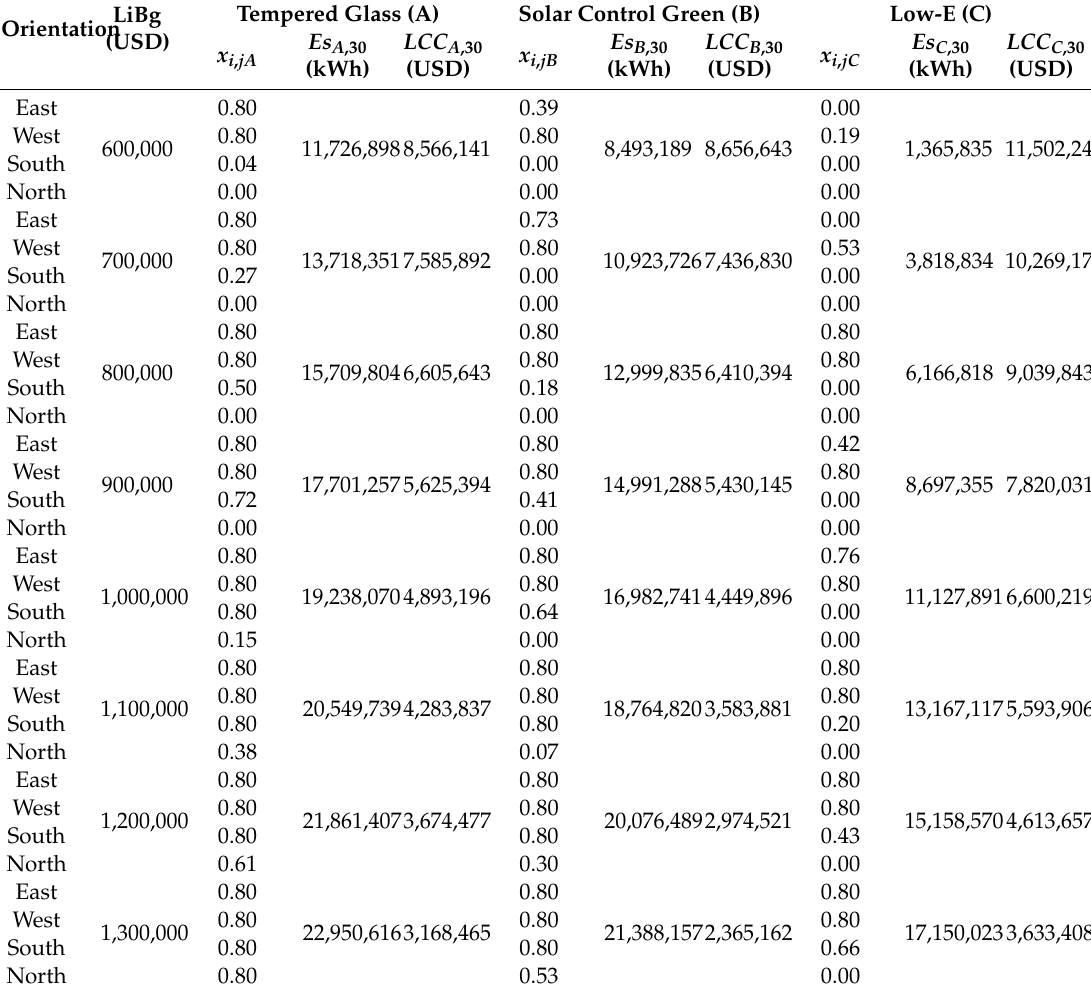
Table 7. The results of data